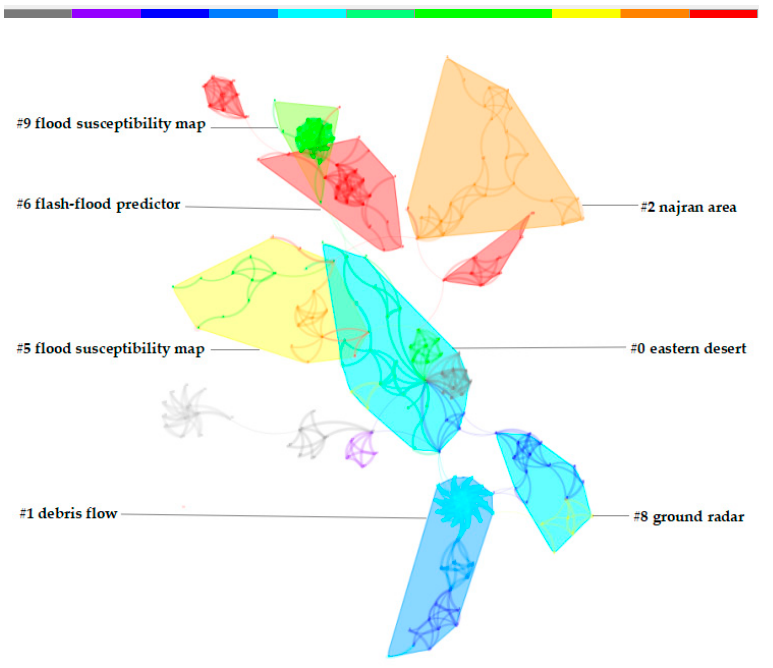
Figure 6. Reference co-citation network for the 248 included articles (clustered according to index terms).